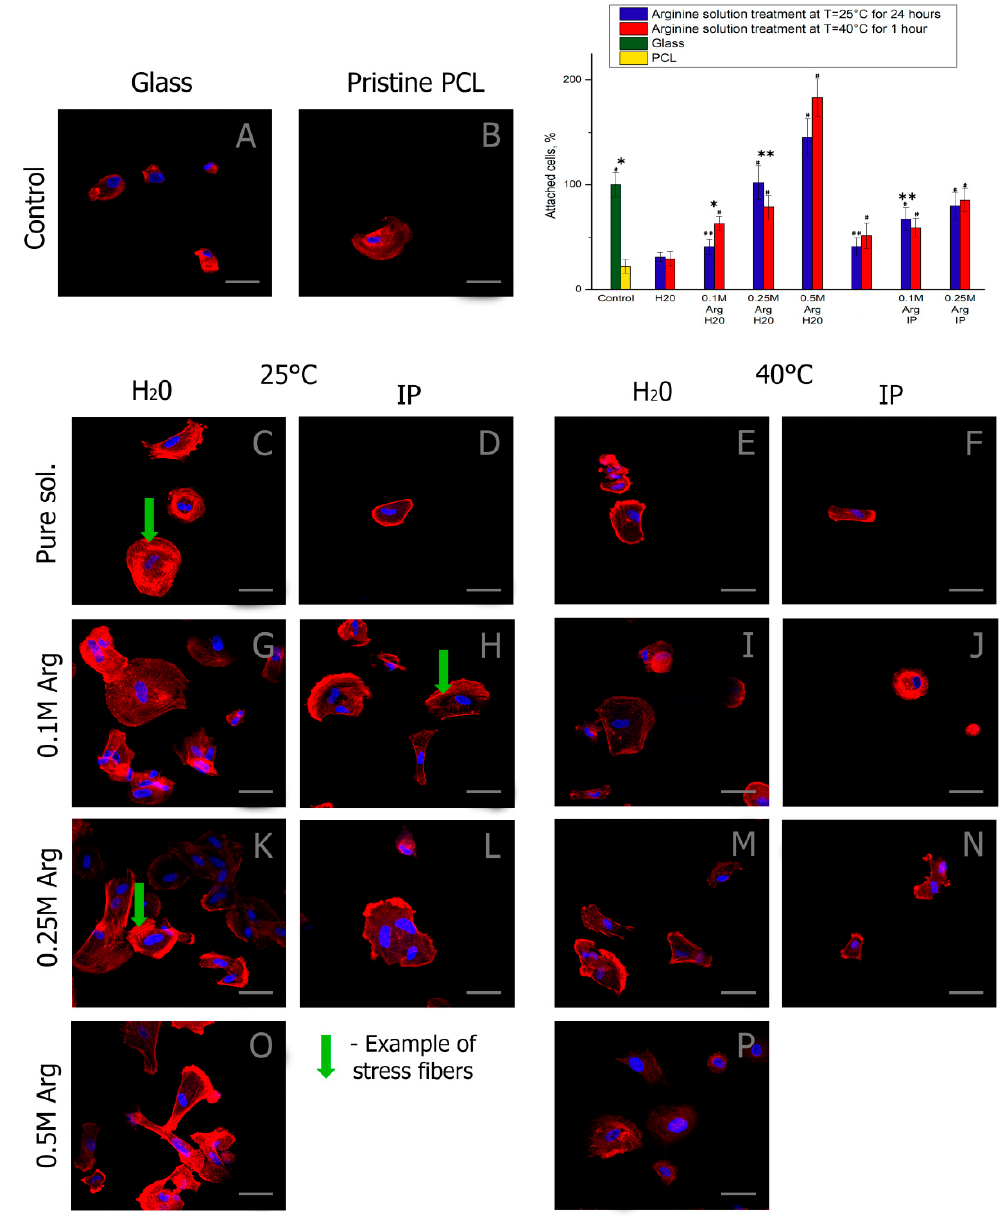
Figure 5. Fluorescence micrographs of Mesenchymal stem cells (MSCs) with actins (red) and nuclei (blue) stained after 2 h cultivation: ( A ) on the pure glass, ( B ) on the pristine PCL, ( C ) on the film treated with water for 24 h at T = 25 ◦ C, ( D ) on the film treated with water / isopropanol (3:1) for 24 h at T = 25 ◦ C, ( E ) on the film treated with water for 1 h at T = 40 ◦ C, ( F ) on the film treated with water / isopropanol (3:1) for 1 h at T = 40 ◦ C, ( G ) on the film treated with the 0.1 M arginine solution in water for 24 h at T = 25 ◦ C, ( H ) on the film treated with the 0.1 M arginine solution in water / isopropanol (3:1) for 24 h at T = 25 ◦ C, ( I ) on the film treated with the 0.1 M arginine solution in water for 1 h at T = 40 ◦ C, ( J ) on the film treated with the 0.1 M arginine solution in water / isopropanol (3:1) for 1 h at T = 40 ◦ C, ( K ) on the film treated with the 0.25 M arginine solution in water for 24 h at T = 25 ◦ C, ( L ) on the film treated